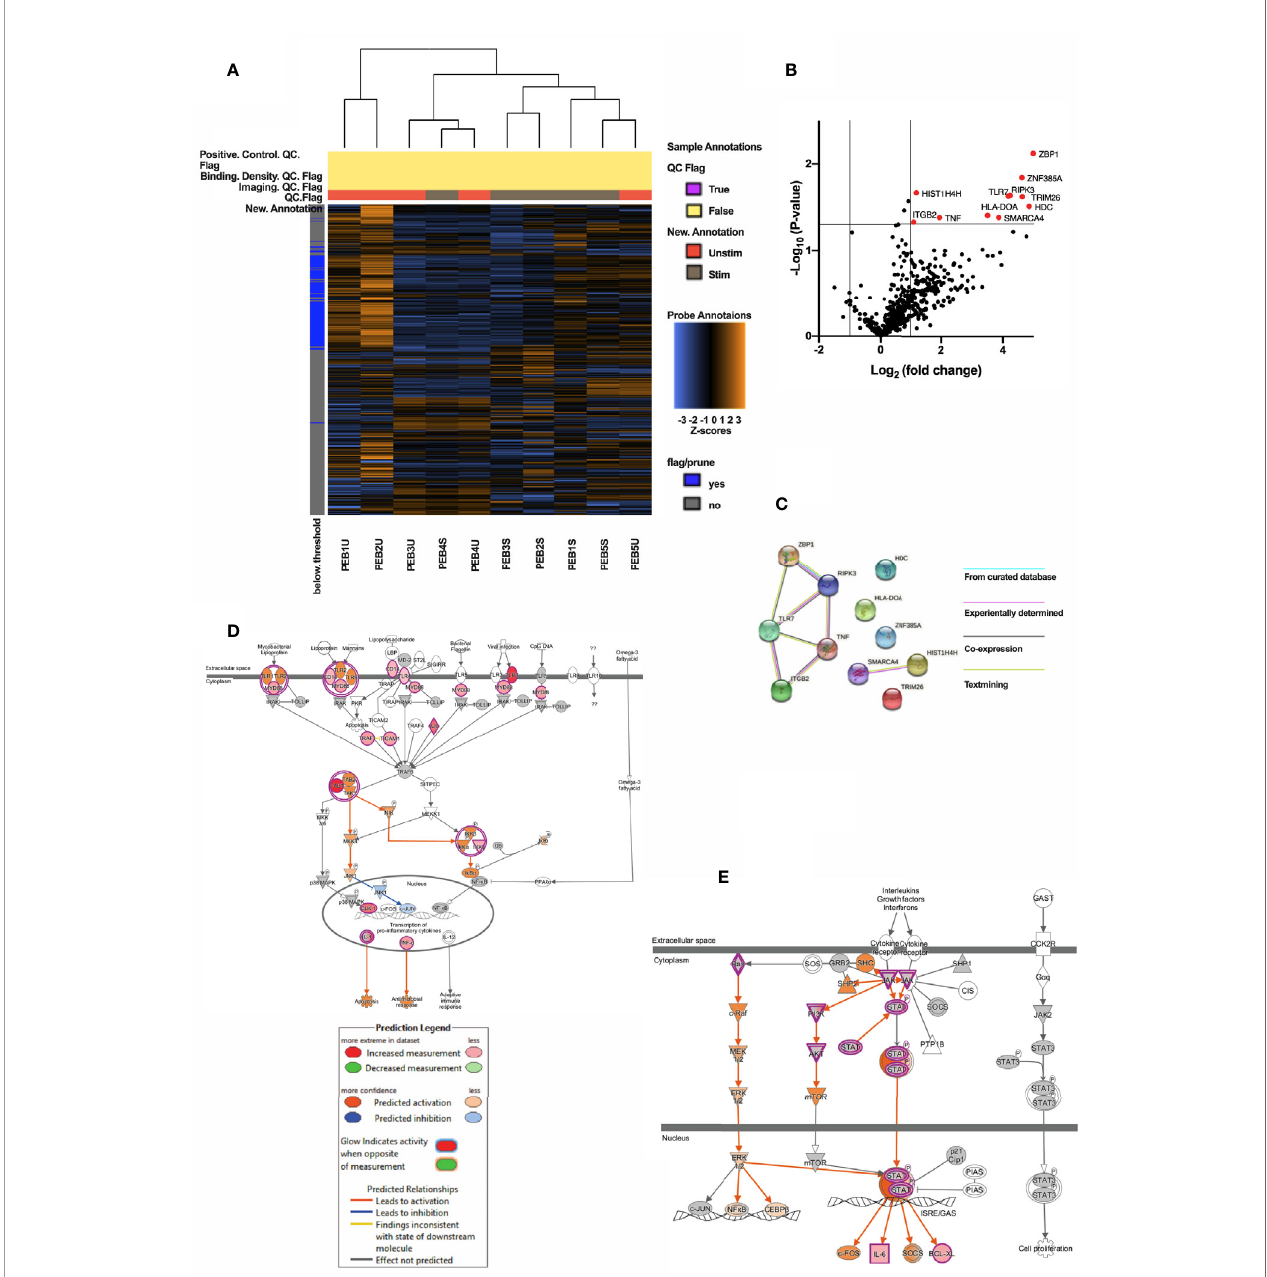
FIGURE 2 | (A) Heatmap showing clustering of PEB stimulated pDCs and PEB unstimulated pDCs. (B) Volcano map showing 11 signi fi cantly upregulated genes (red, Log2(fold change) >1 and p<0.05) in stimulated vs unstimulated entheseal pDCs. Gene symbols were displayed if Log2|fold change| > 1. (C) PPI network of the 11 DEGs showing a main component consisted and 4 isolated nodes. Lines connecting two nodes represent protein-protein associations. Pathway mapping analysis of pDCs generated by IPA revealed the toll-like receptor signaling (D) and JAK/STAT signaling (E) among the topmost canonical pathways enriched upon treatment with ODN. Stimulation of TLRs leads to activation of MYD88 and fi nally transcription of pro-in fl ammatory cytokines including TNF (D) . Activation of JAK leads to activation of STAT or PI3K pathway, which is predicted by IPA (E) . Prediction legend is shared by 2D and 2E. Red & pink represents upregulation and intensity represents the relative magnitude of change in gene expression. Predicted activation indicated by orange color and blue for the predicted inhibition. Direct and indirect interactions are indicated by solid and dashed lines,